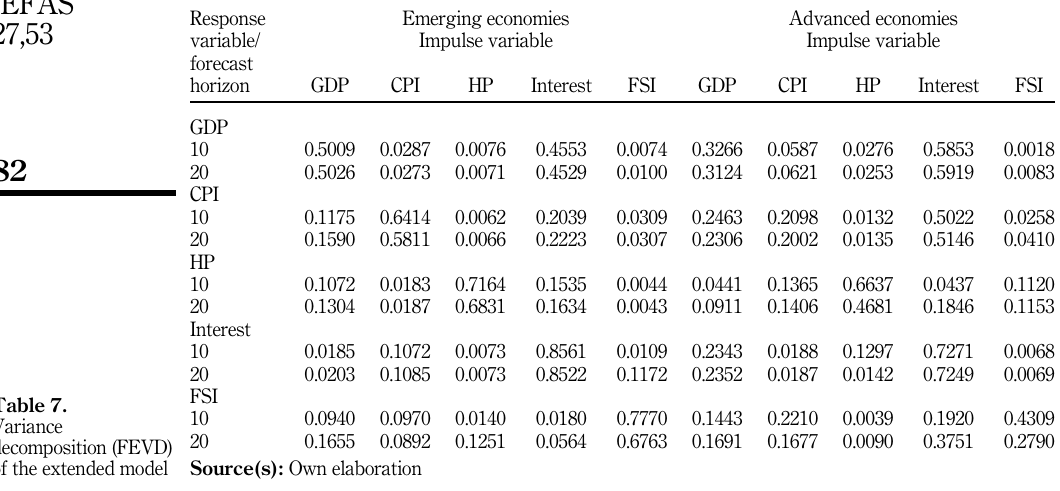
decomposition (FEVD) of the extended